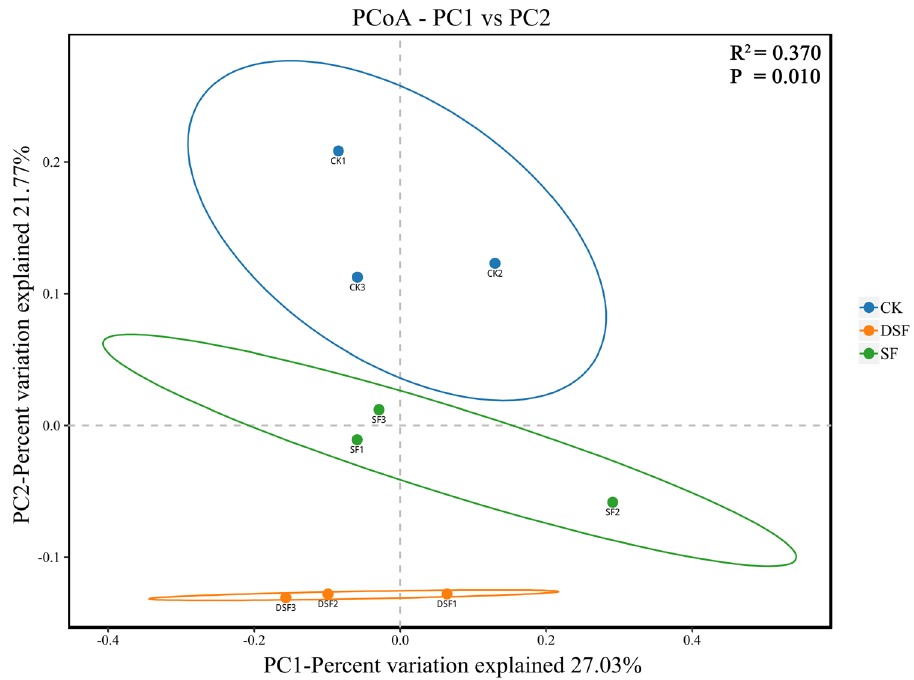
Figure 5. Bray–Curtis Principal coordinates analysis of rice rhizosphere microorganisms under different fertilization modes of slow-release fertilizer.